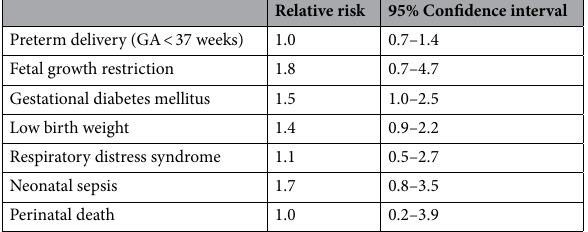
Relative risk 95% Confidence